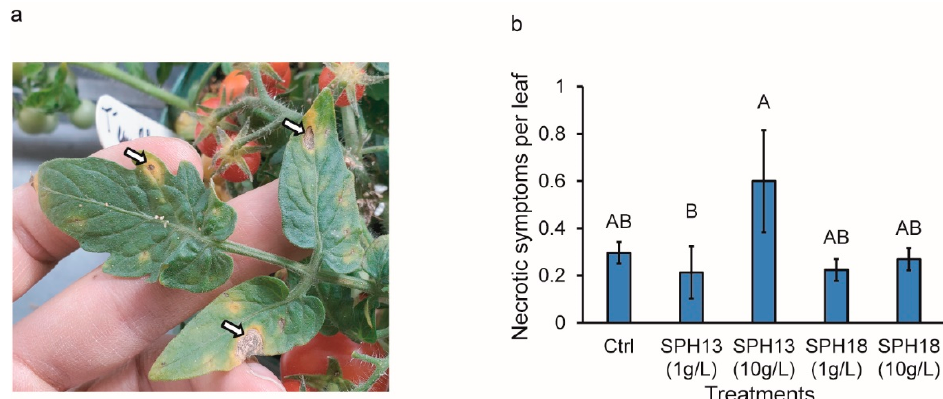
Figure 4. ( a , b ) Impact of one SPH drench application on ‘Micro Tom’ plant resistance to Botrytis cinerea . ( a ) The picture shows B. cinerea induced necrotic lesions on leaves. ( b ) Average number of necrotic lesions per leaf calculated for each plant by dividing the total number of necrotic lesions by the number of leaves ( n = 5, one-way ANOVA with post hoc LSD, p < 0.05, means with the same letter are not significantly different). ( a , b ) Tomato seeds were sown on 3 February 2022.